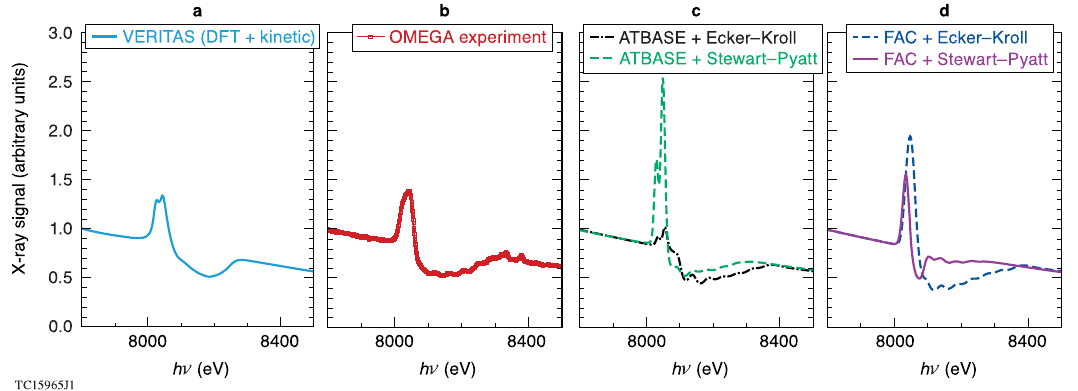
Fig. 3 | Comparison of time-integrated K α -emission and 1s-2p absorption sig- nals between experiment and models. a The DFT-based VERITAS calculations. b The experimental measurement. c The CRE model calculations with atomic database (ATBASE) in combination with Stewart – Pyatt and Ecker – Kroll continuum